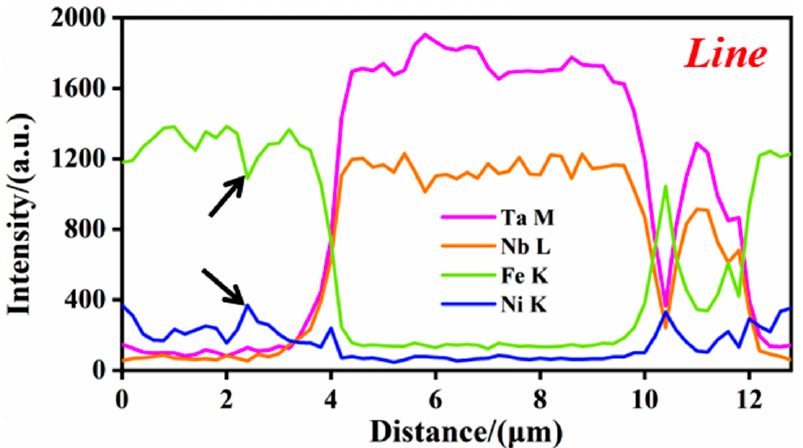
Figure 5. The EDS line profile of element concentration in the typical area in Figure 4.